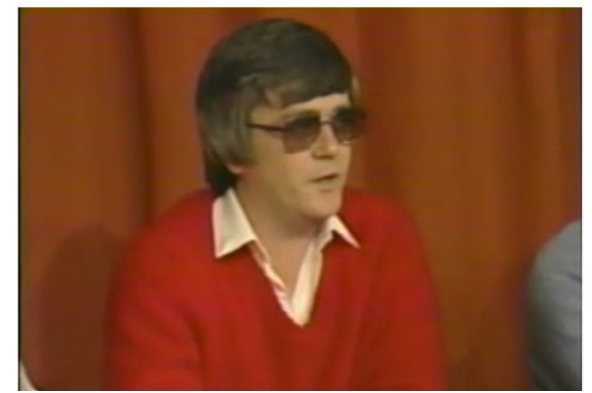
Figure 3. Former Buchans Mayor Sean Power during the 1985 Buchans Transmitter Program. Screenshot from Memorial University of Newfoundland, Digital Archives